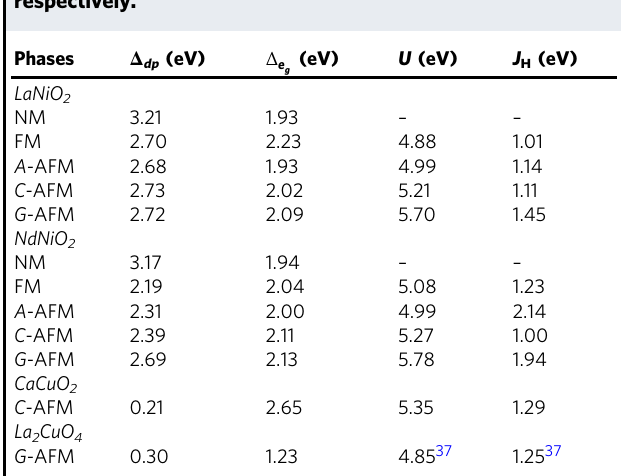
denote the splitting of e g